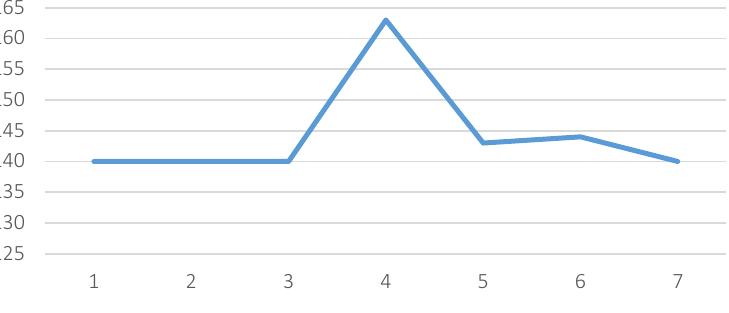
Figure 5. Number of employees during